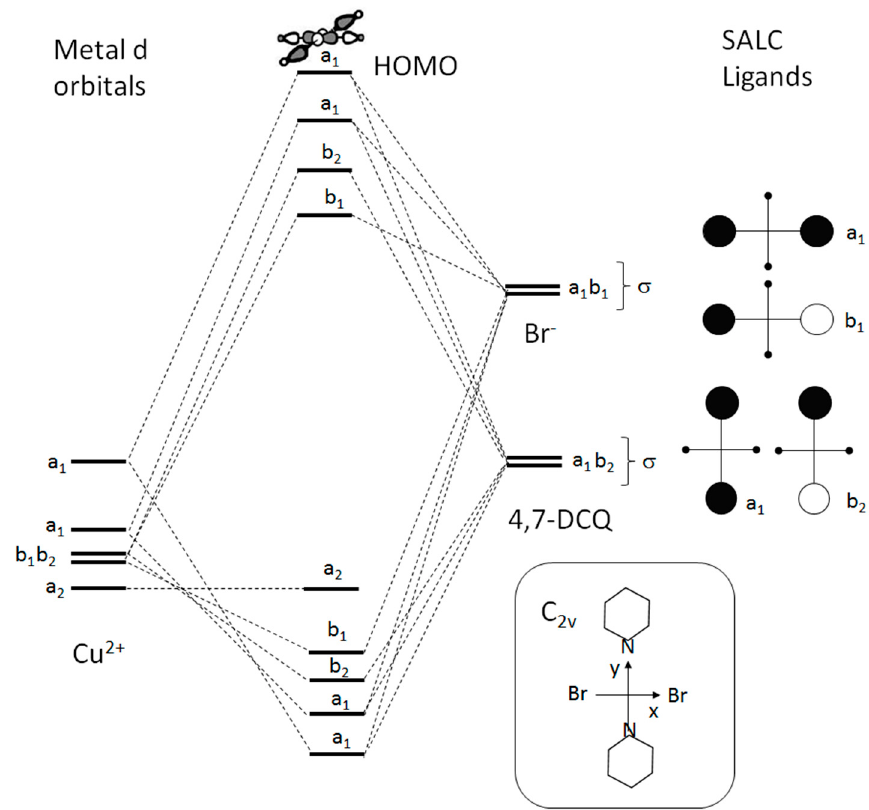
Figure 6. Simplified C 2v -idealized valence interaction diagram of each Cu(4,7-DCQ) 2 Br 2 unit in the stoichiometric CDCQB binuclear complex. A d 9 configuration of the Cu 2+ ion and fully occupied SALC of ligands are assumed. Table 3. Mulliken net atomic charges (electrons) of relevant symmetry-independent chemical moieties in CDCQB, as obtained from M06 / TZVP calculations on isolated complexes a